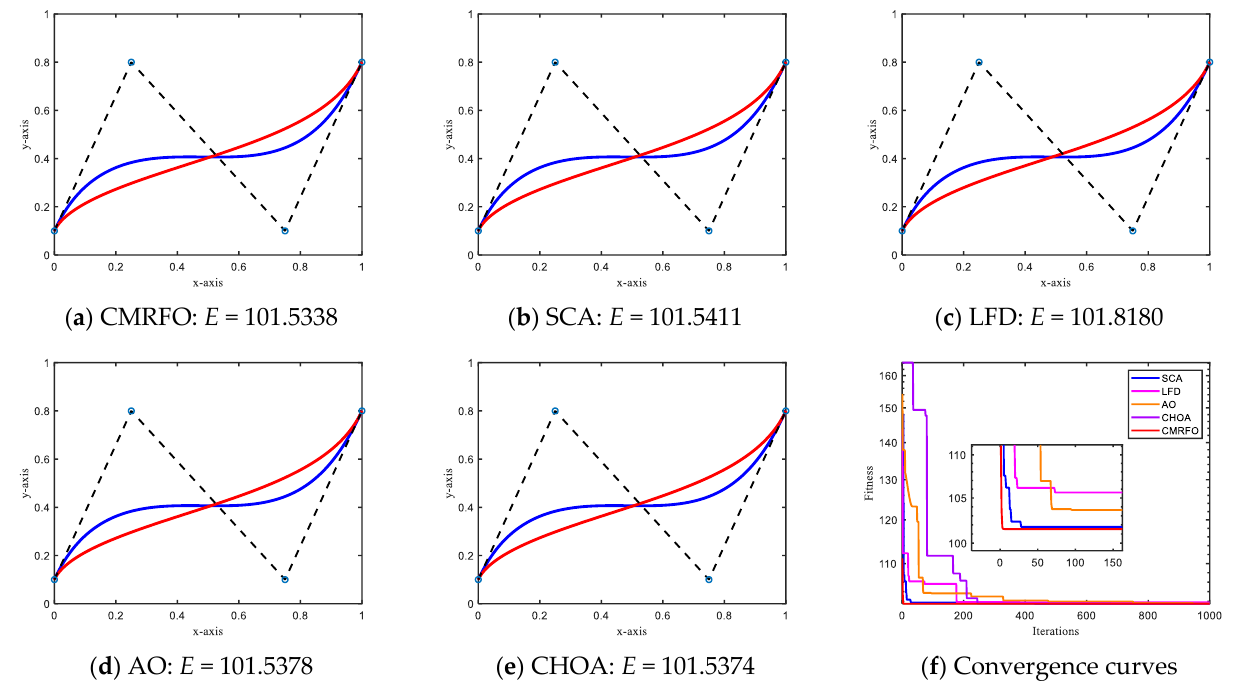
Figure 11. Shape optimization of CG-Ball curves. Table 16. Optimal values of shape parameters and corresponding objective function.